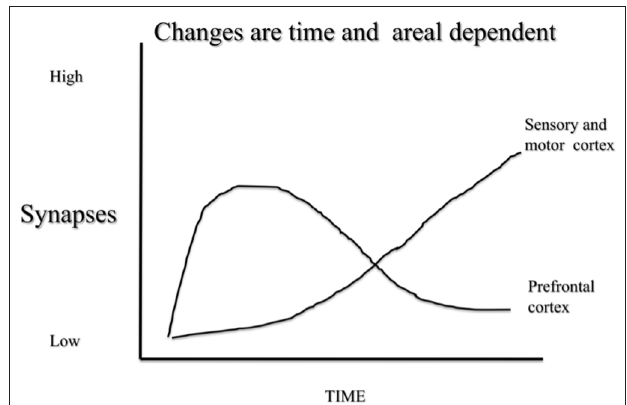
FigurE 2 | A schematic illustration of synaptic change in response to complex housing in rats. Pyramidal neurons in prefrontal cortex shows acute changes that revert by baseline in about 10 days. In contrast pyramidal neurons in sensory and motor regions show a slower change that remains months after